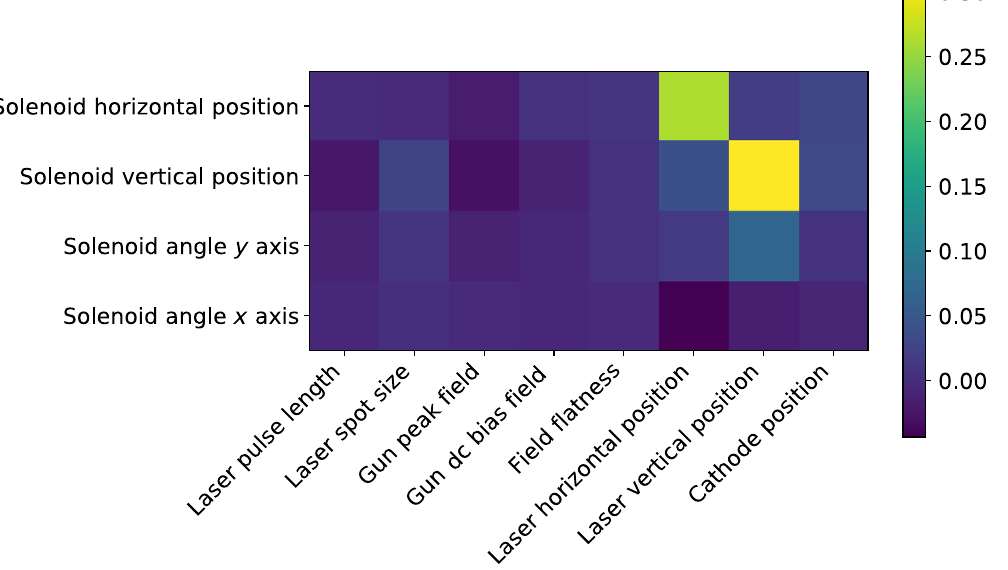
FIG. 8. Average of the Jacobian matrix of 100,000 state values and their chosen actions; A high value in the color scale means the average of the partial derivatives is high. It turns out that great changes in the laser horizontal position and vertical position lead to great changes in the respective solenoid position in the policy of our RL agent.